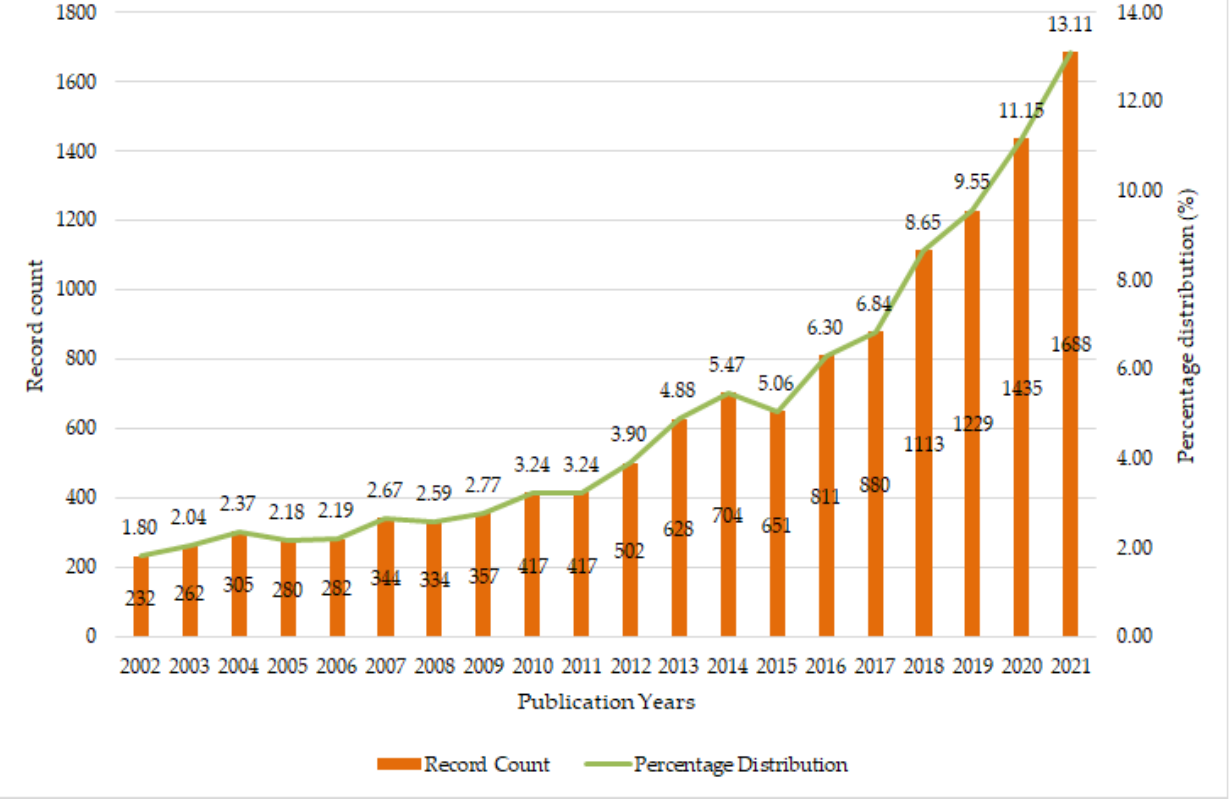
Figure 1. Bar graph showing frequency of publications from 2002 to 2021 . Table 1. Percentage distribution of prefab publications according to publishers .